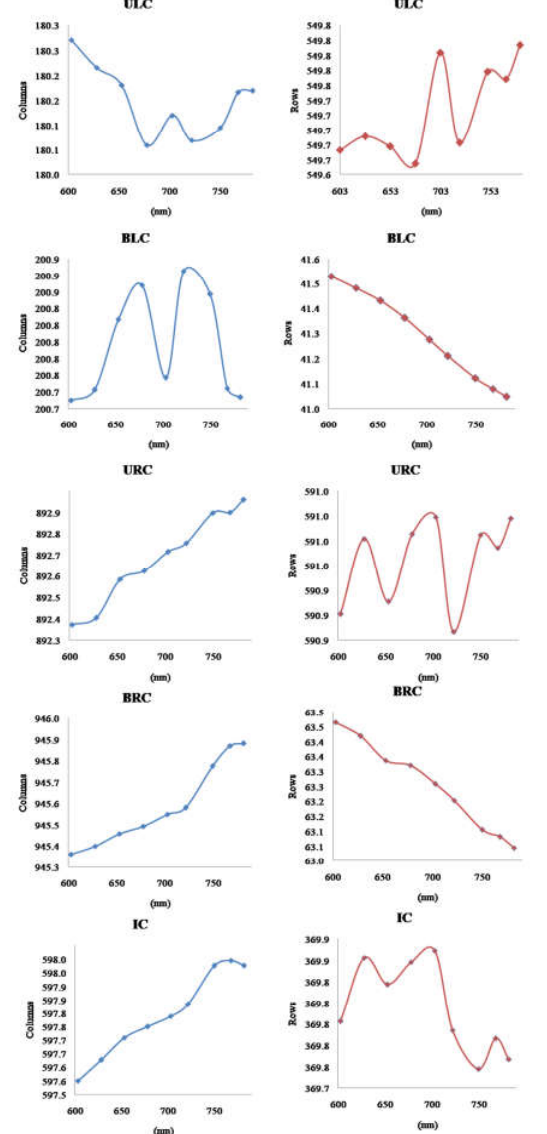
Figure 4. Effect of air-gap variation in the image coordinates of targets for sensor II.